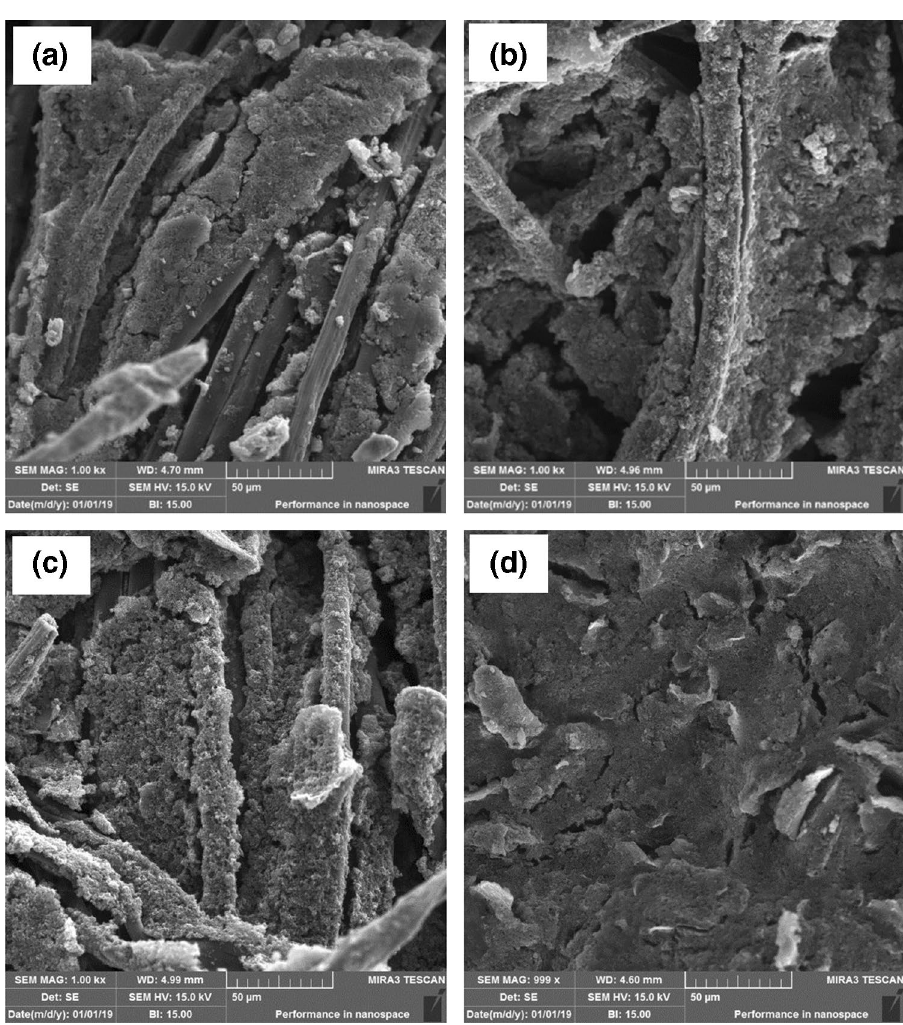
Fig. 4 FE-SEM images of the surface of PANI/GNS coated fabric containing a 0.5 wt% GNS, b 2.5 wt% GNS, c 5 wt% GNS and d 10 wt%